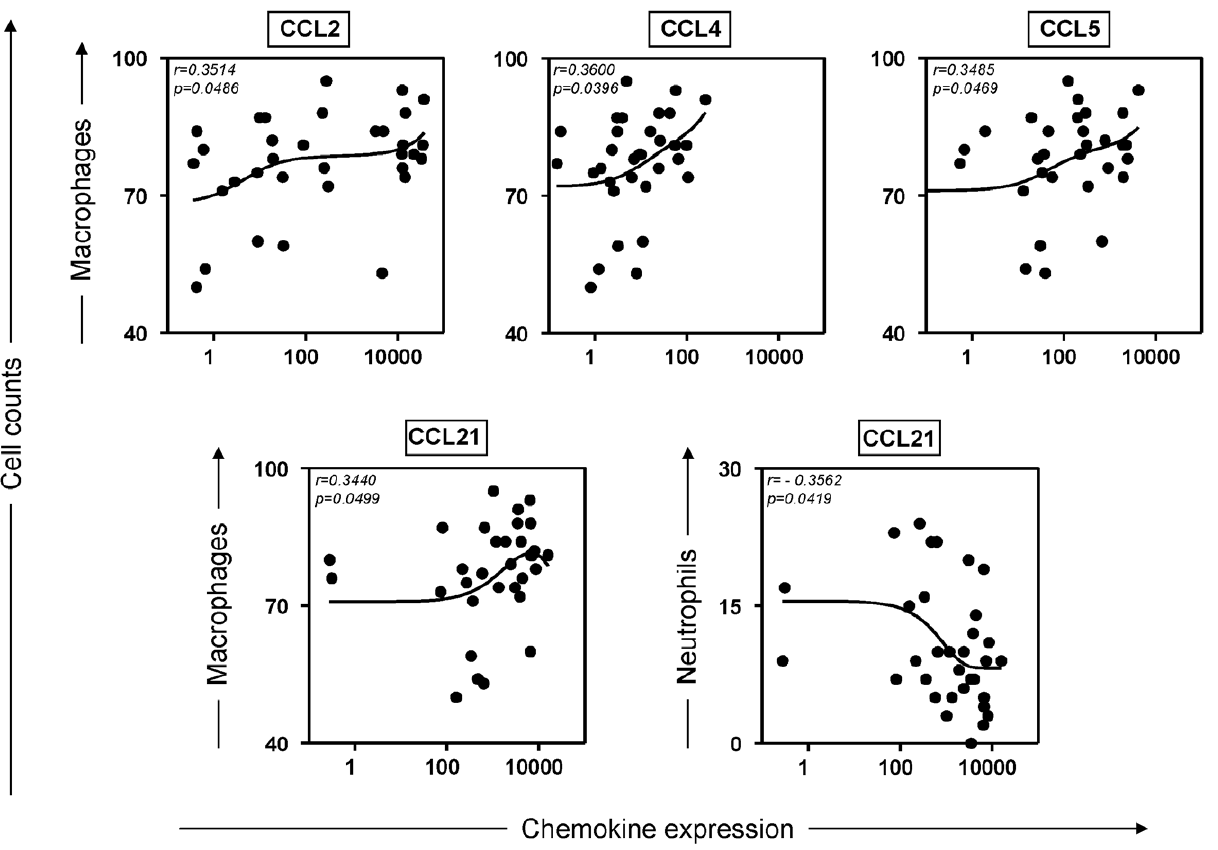
Figure 4. Correlation between parasite density (LDU) and cell-types presenting into skin from L.infantum infected dogs. The results were expressed on graphs as scattering of individual values. Spearman correlation indexes ( r ) at p , 0.05 are shown on graphs. Connecting lines illustrated positive and negative correlation indexes.